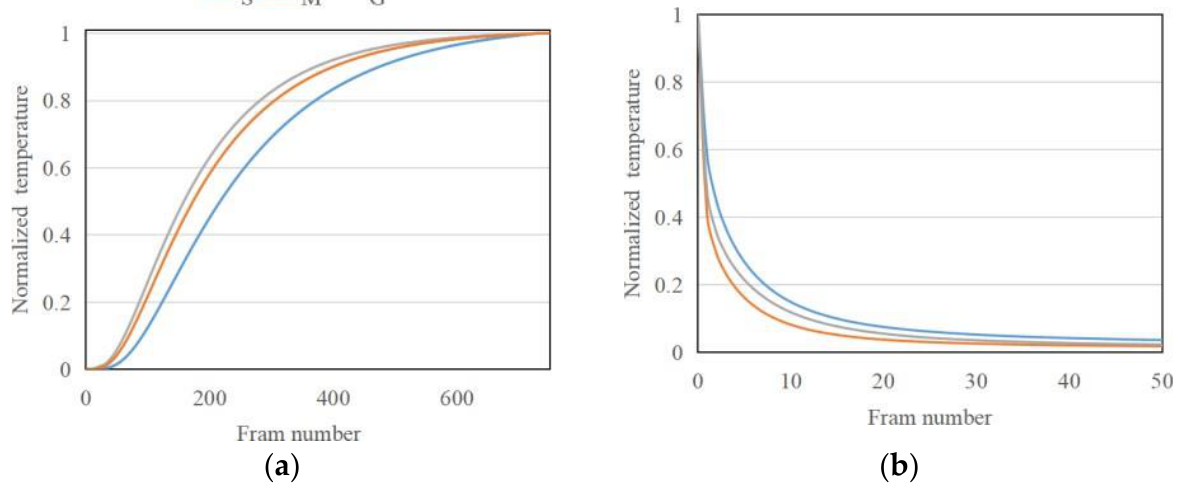
Figure 12. Thermal response in ( a ) transmission (single-layer material) geometry and ( b ) reflection geometry (two-layer material).